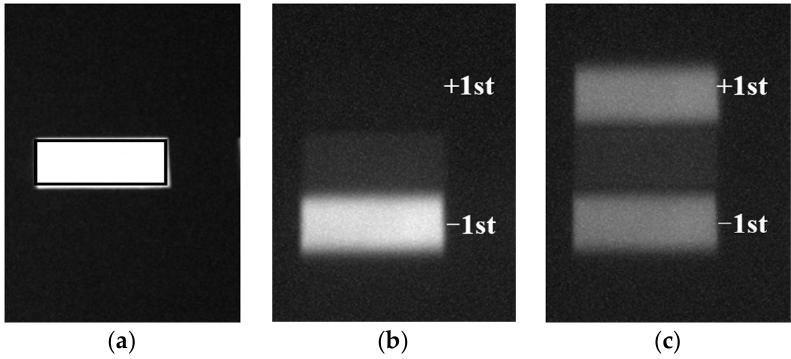
Figure 8. ( a ) Raw image; polarization image of QWP at ( b ) 0°and ( c ) 45°.